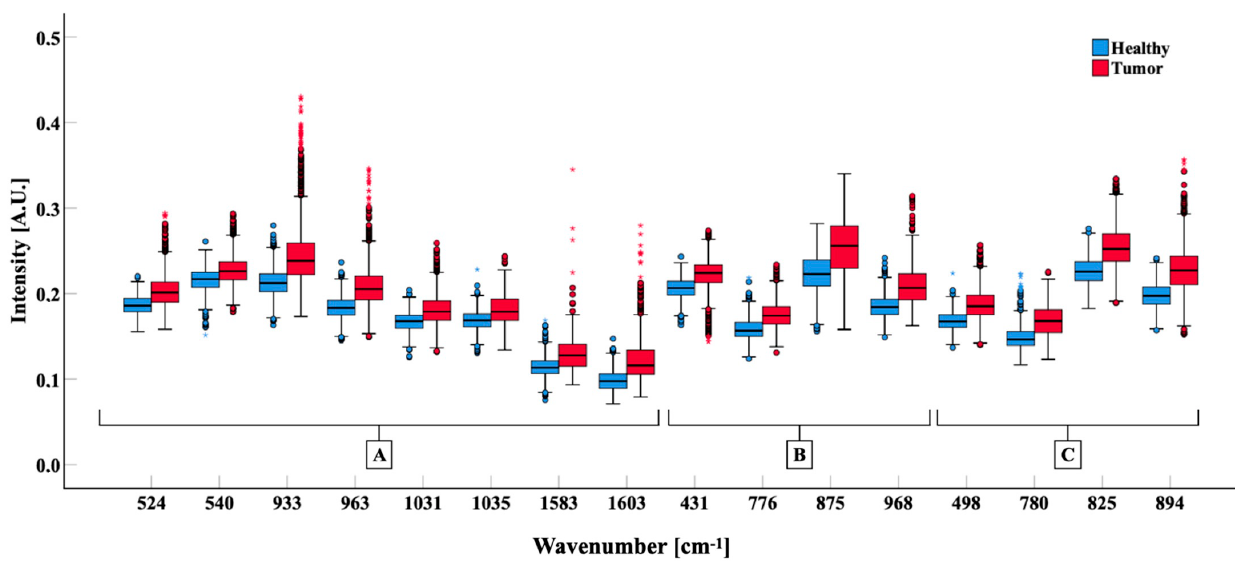
Figure 4. Comparison of the band intensities of Healthy ( blue ) and Tumor ( red ) biopsies grouped for biological significance. Box-plots show 25°, 50°, 75° percentiles (box) and 5°–95° (whiskers) percentile of data distribution; the median of groups is indicated with a black bar. Mann–Whitney test was calculated for all bands showed ( p < 0.001). ( A ) bands related to protein. ( B ) bands related to lipids. ( C ) Bands related to nucleic acids.